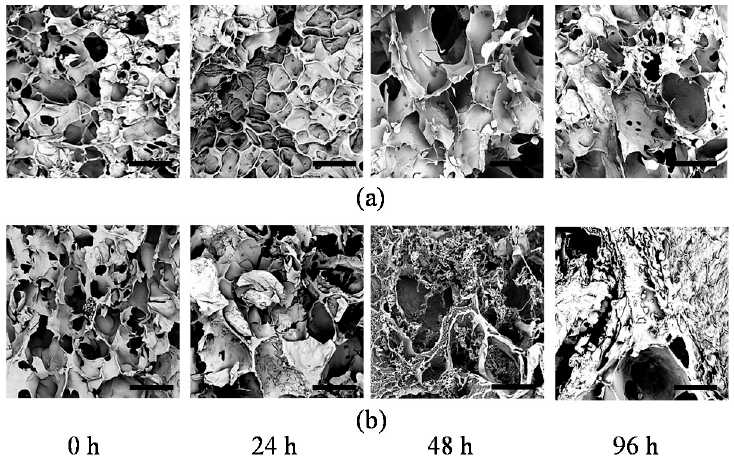
Figure 9. SEM images showing pore sizes after different hours of incubation for ( a ) 10% GelMA with no encapsulated cells and ( b ) 10% GelMA with a cell density of 5 × 10 6 cells/mL (scale bar represents 300 µm).